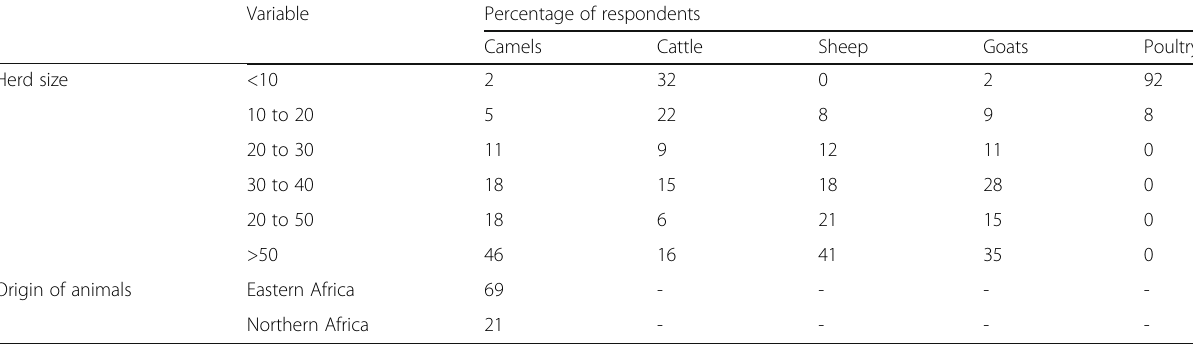
Table 1 Herd size and origin of camels in Northeastern Nigeria Variable